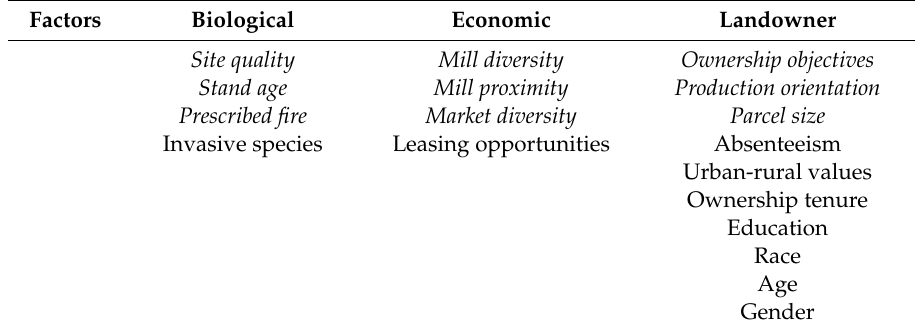
Table 2. Possible factors* associated with adoption of mixed-stand management